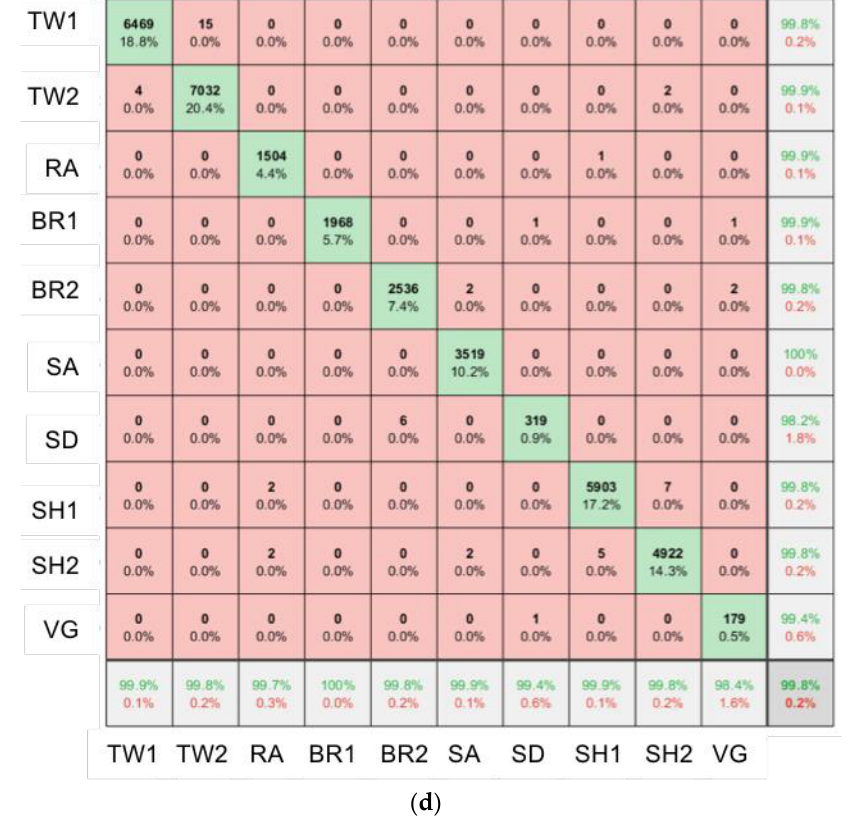
Figure A2. Overall confusion matrix from the neural network classification for ( a ) Iriri; ( b ) Culuene; ( c ) Xadá; ( d ) Retroculus. PO = Podostemaceae, CO = Cobbles, BR = Bedrock, SH = Shallow water, SD = Shadow, VG = Vegetation, TW = Turbid water, WW = White water, SA = Sand, RA = Gravel Assemblage. Y axis represents the target class, X axis represents the output class.